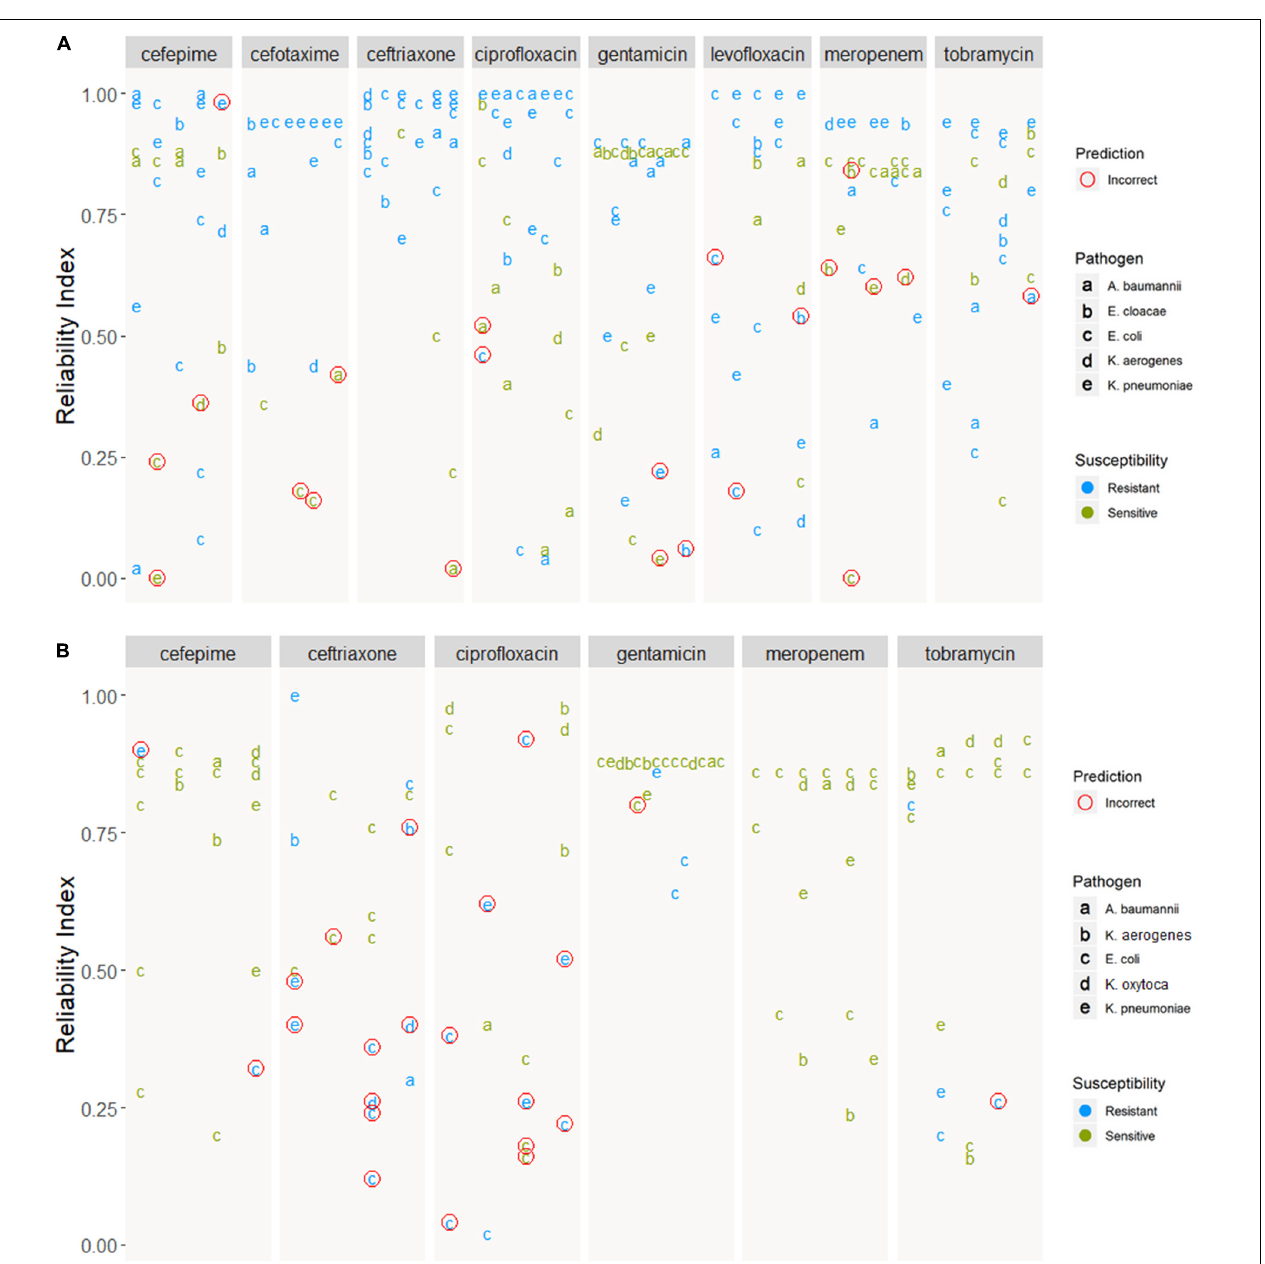
FIGURE 7 | Prediction of samples from the (A) Demo and (B) In-house datasets. Predictions are grouped by antibiotic and ordered by reliability index. Incorrect predictions encircled in red, predictions with no known resistance in the meta-data are not shown. In-house dataset was not tested for cefotaxime and levofloxacin, hence these two ABs are not